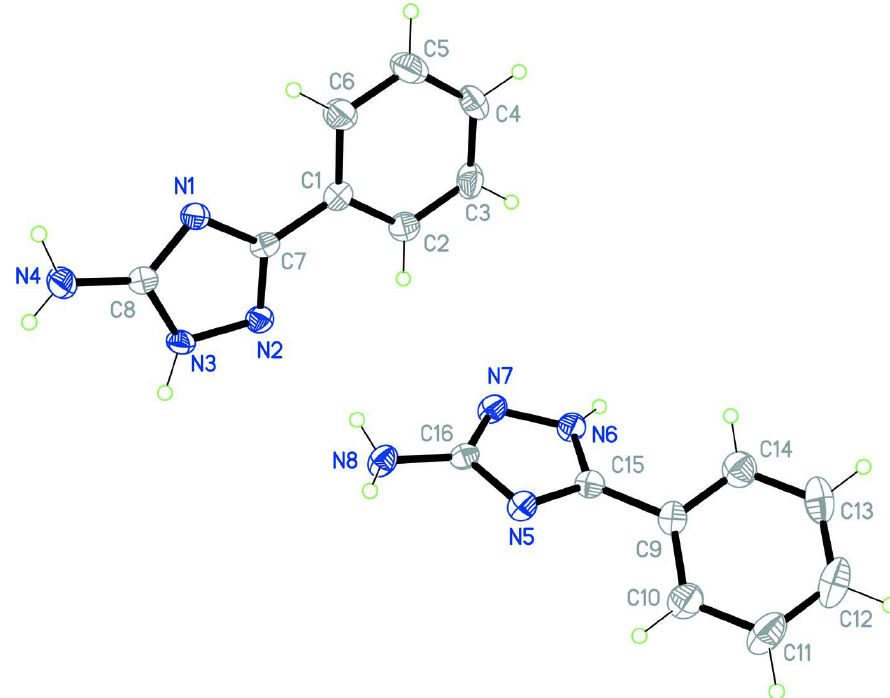
Figure 2 The molecular structure of 3(5)-phenyl-1,2,4-triazol-5(3)-amine with the atomic numbering scheme. Displacement ellipsoids are drawn at the 50% probability